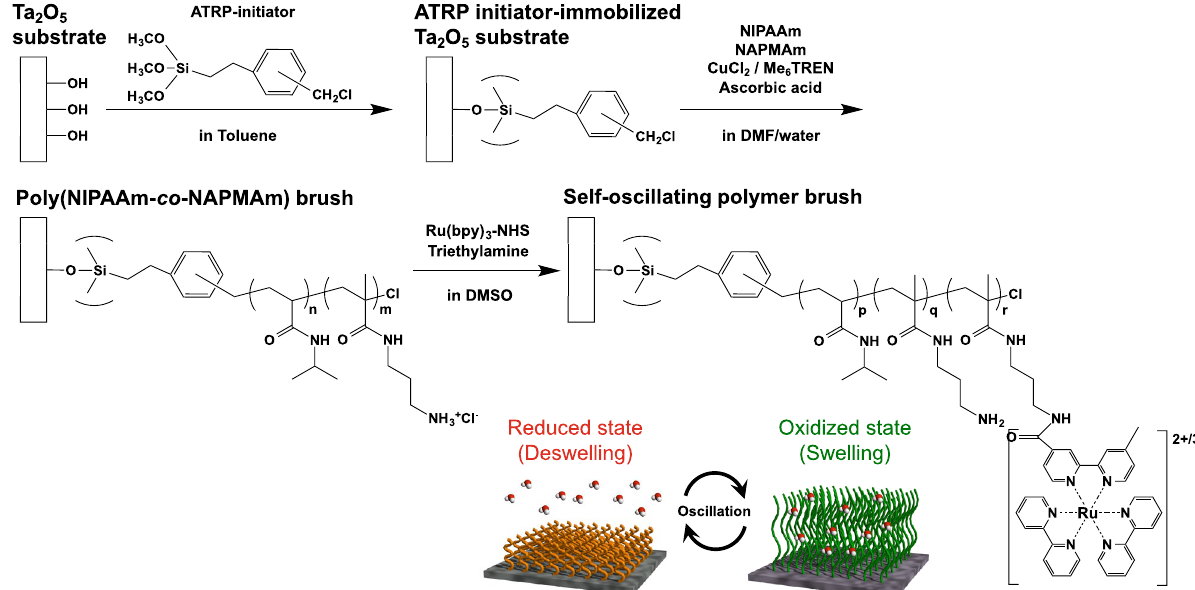
Figure 5. Poly(NIPAAm- r -NAPMAm- r -Ru(bpy) 3 NAPMAm) brush grafted on Ta 2 O 5 gate surface by SI-ARGET ATRP. These illustrations were drawn using the software (ChemDraw ver. 13.0 and Shade 3D ver.